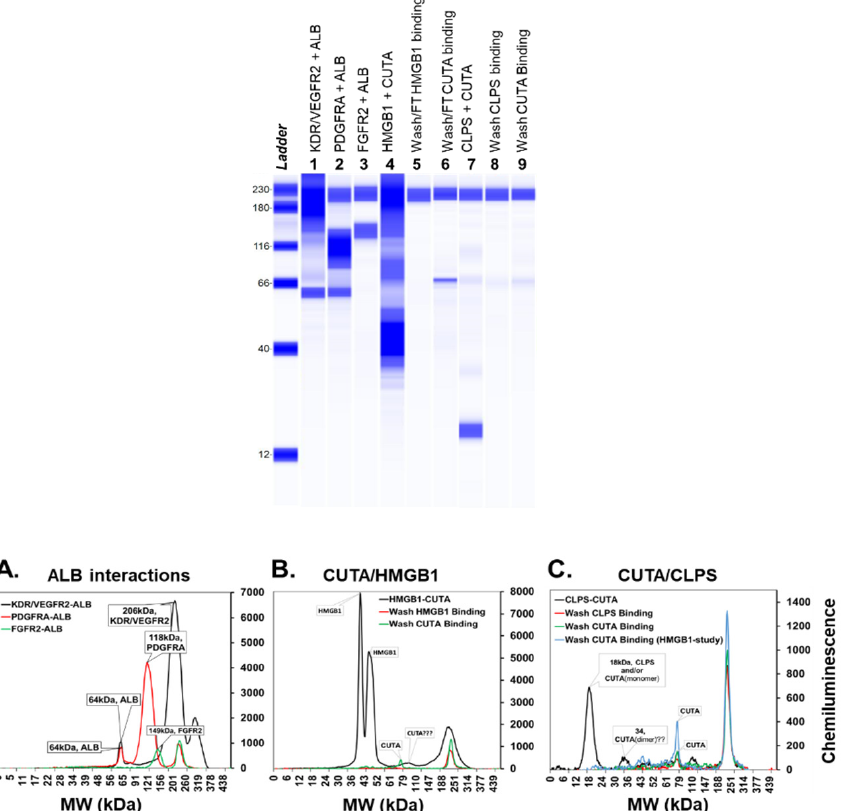
Figure 3. Validation of predicted ALB interactions and CUTA interactions using Wes™ Simple Western total protein detection assay: Pseudo-gel or virtual-blot like image of the validated interactions of ALB (lanes 1–2) and CUTA (lanes 4, 7) along with negative control (lane 3). In addition to the final pull-down samples, wash and/or flow through after binding ‘bait’ and ‘prey’ proteins for the CUTA interactions are also shown (lanes 5, 6, 8 and 9). The electro-pherogram image of Simple Western results using Total protein size-based assay. ( A ) ALB interactions with true positives KDR / VEGFR2 , PDGFRA and false positive FGFR2 . ( B ) CUTA interactions with HMGB1 . ( C ) CUTA interactions with CLPS . An overlay of the electro-pherogram of the wash from HMGB1 after CUTA binding is also shown in ( C ) for comparison.